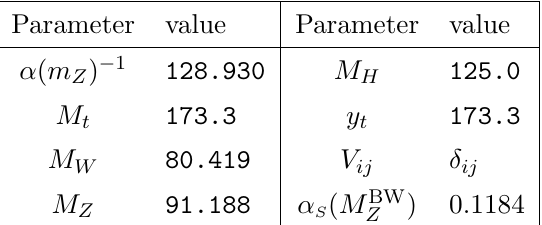
= 91 : 1876 GeV; see also foot- Z